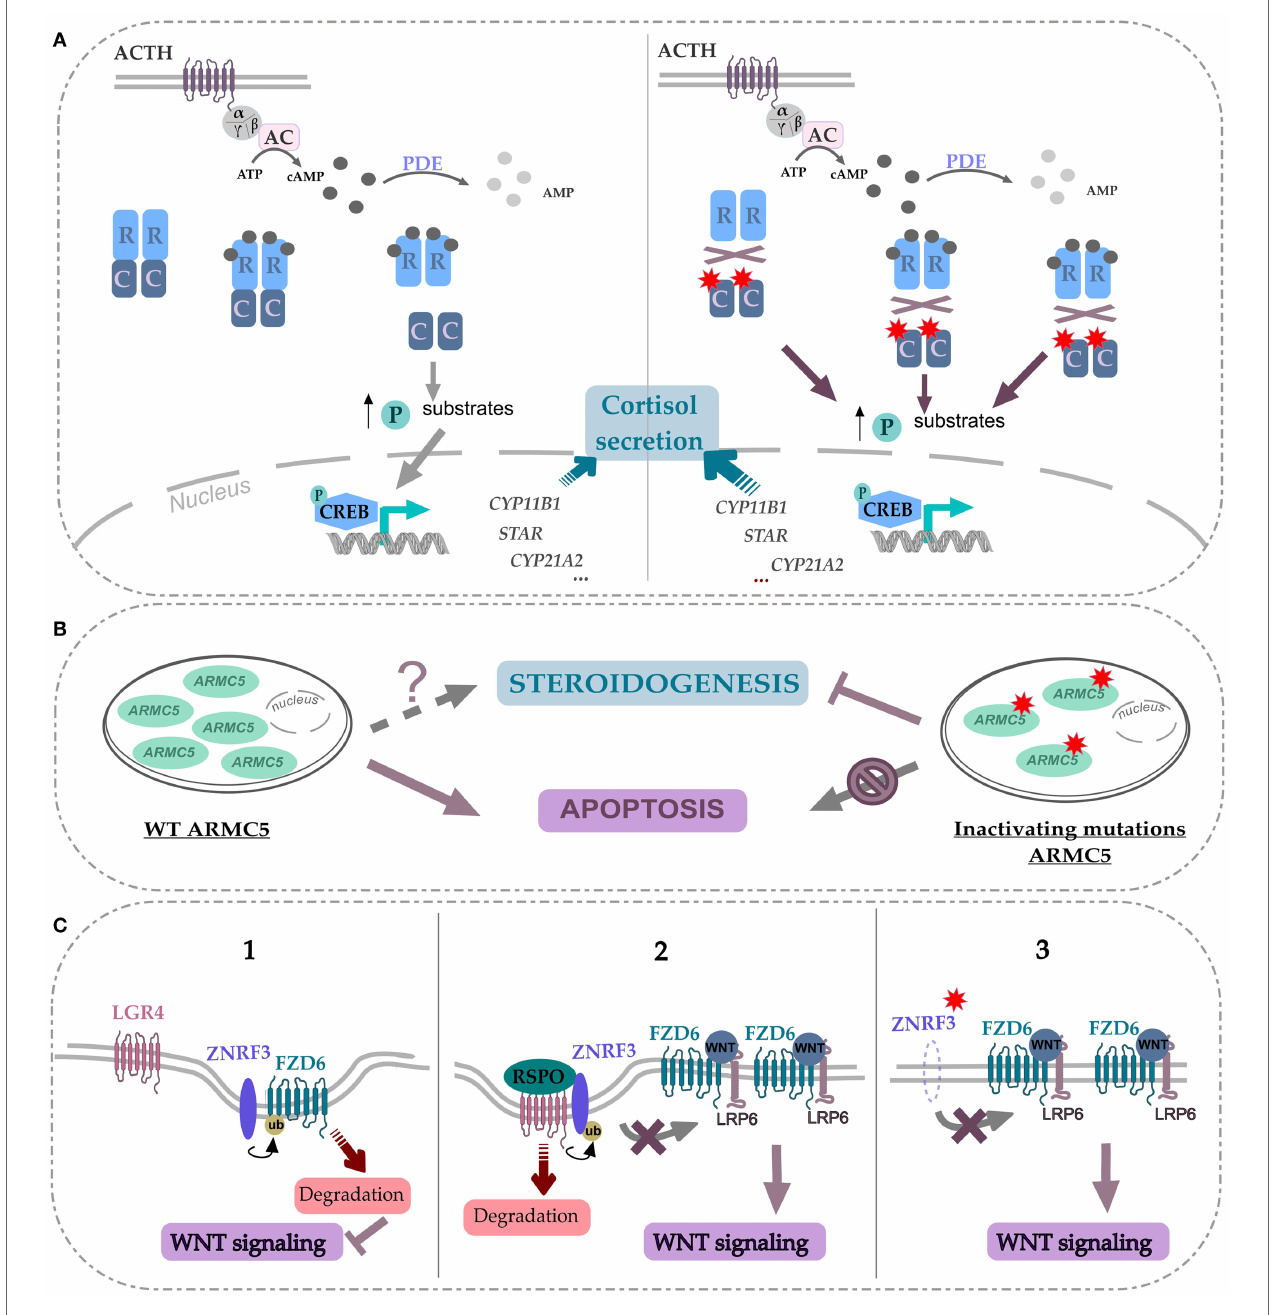
FiguRe 2 | effects of recently identified drivers in signaling pathways involved in adrenal tumorigenesis . (A) Alterations in the PKA pathway caused by PRKACA p.L206R and PRKACA Leu199_Cys200insTrp mutations in adrenocortical adenomas. Under normal conditions, the catalytic and regulatory subunits of PKA form a heterotetramer. In response to ACTH stimulation, the catalytic subunits are released from the complex in an active form. The free catalytic subunits phosphorylate their substrates and thereby increase the transcription of target genes. These target genes are mainly involved in the synthesis of cortisol and other steroids. The p.L206R and Leu199_Cys200insTrp mutations in the PRKACA gene alter its interaction with regulatory subunits of PKA leading to constitutive activation of PKAc α